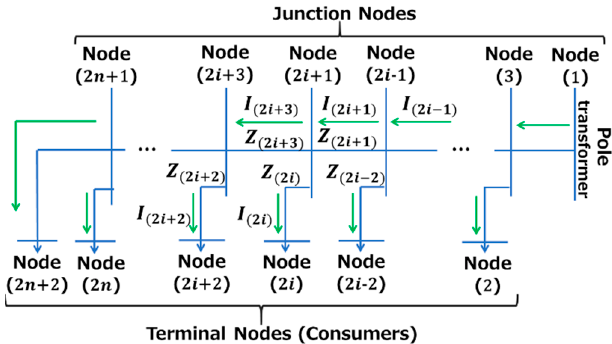
Figure 3. Generalized network model of a secondary distribution network.